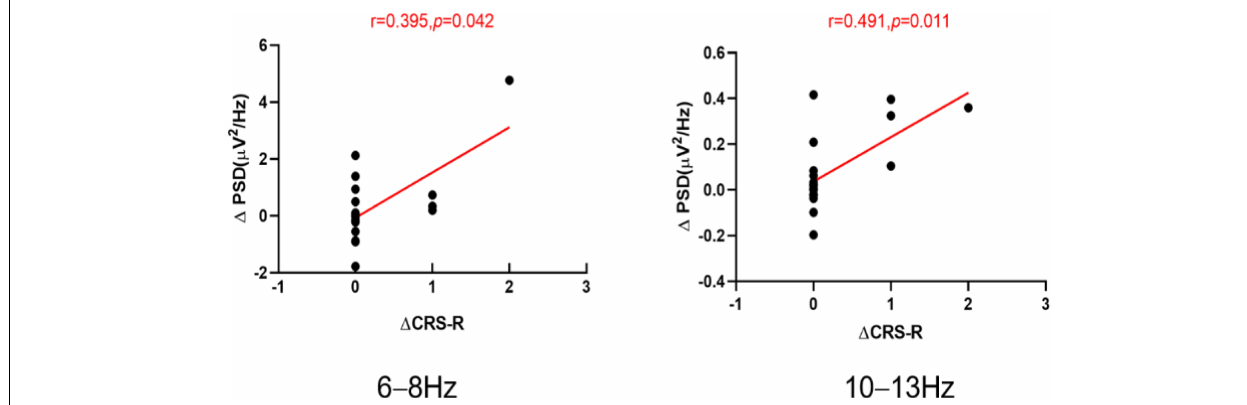
FIGURE 5 | The scatter plots of the (cid:49) CRS-R and (cid:49) PSD at the 6–8 and 10–13 Hz band for all the patients, (cid:49) CRS-R the increases in the Coma Recovery Scale-Revised (CRS-R) scores at T1 compared with T0. (cid:49) PSD the increases in the power spectrum density (PSD) at T1 compared with T0. T0 before the experiment. T1 after a single session of